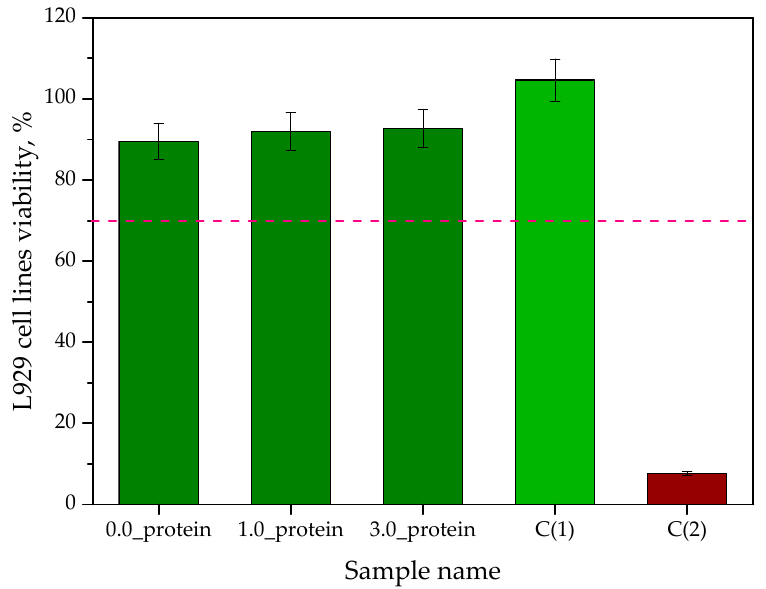
Figure 12. The viability of mouse fibroblasts (L929 cell lines) in the MTT reduction assay ( n —number of repetitions n = 3).